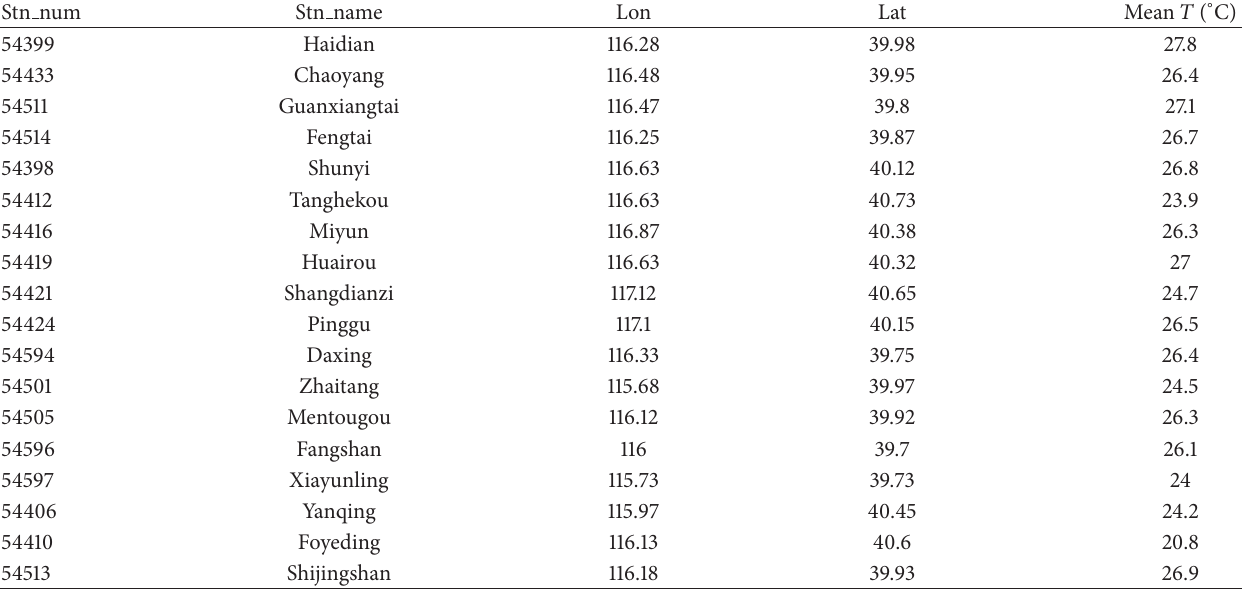
Table 3: Coordinates of the daily temperature measurement